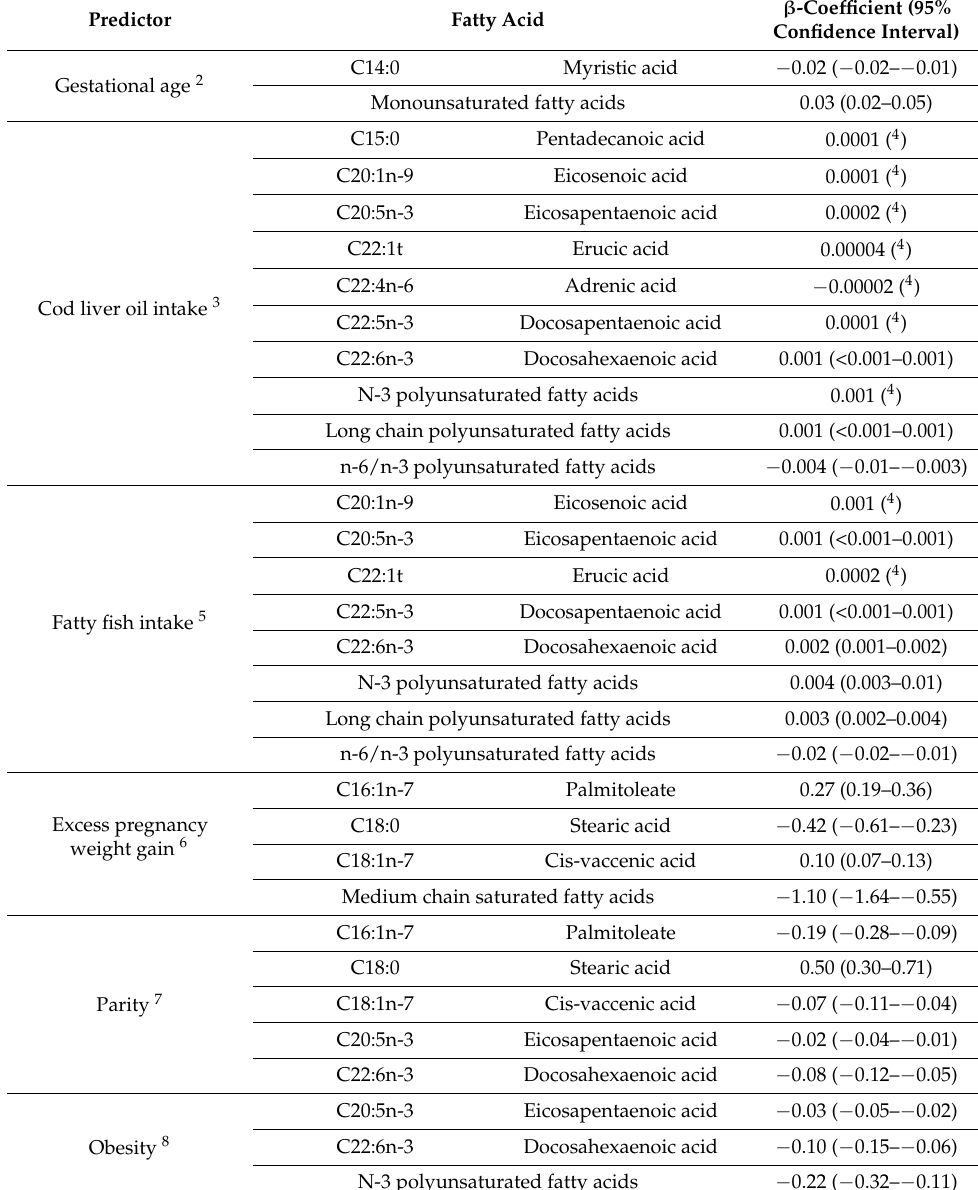
Table 4. Notable maternal predictors of triglyceride fatty acid percent composition in milk from Norwegian mothers 1